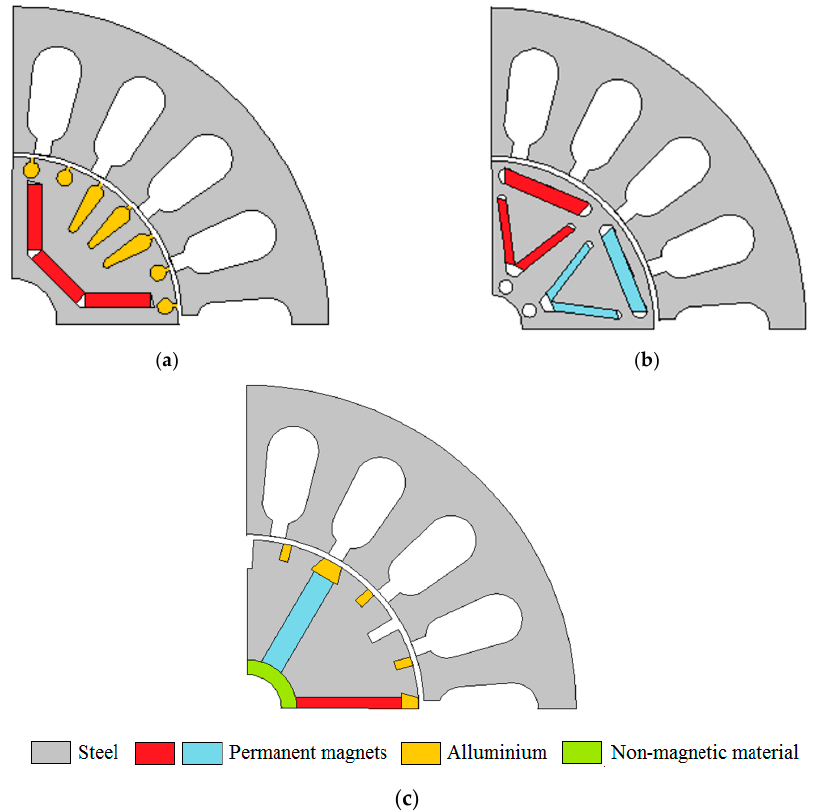
Figure 1. The modern structures of PM motors: ( a )LSPMSM; ( b ) PMSM with delta shape magnets; ( c ) LSPMSM with composite solid rotor.